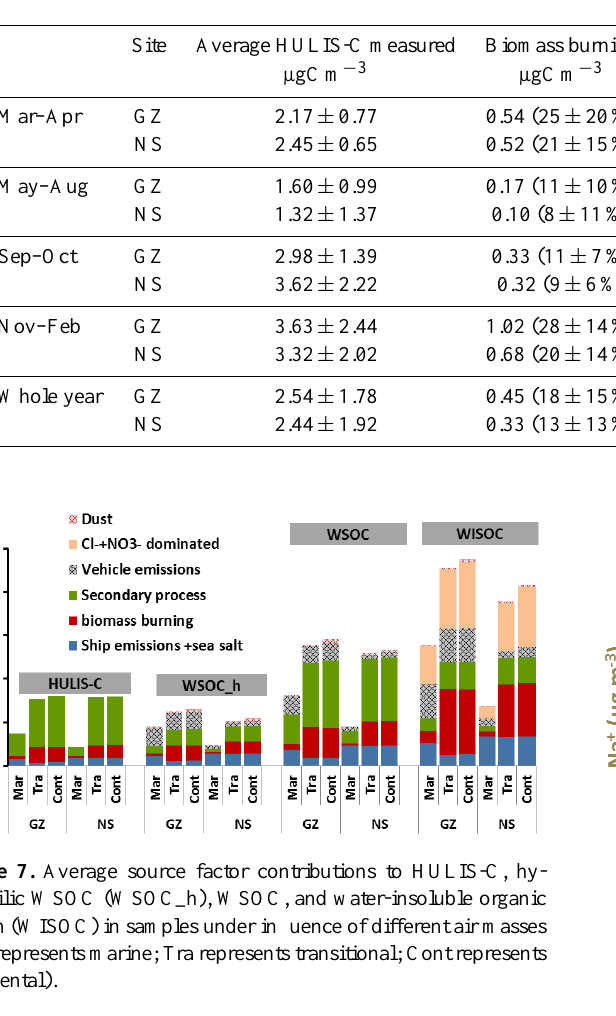
Figure 8. Correlations of Na + and V with HULIS-C at NS on sum- mer days under influences of air masses of marine